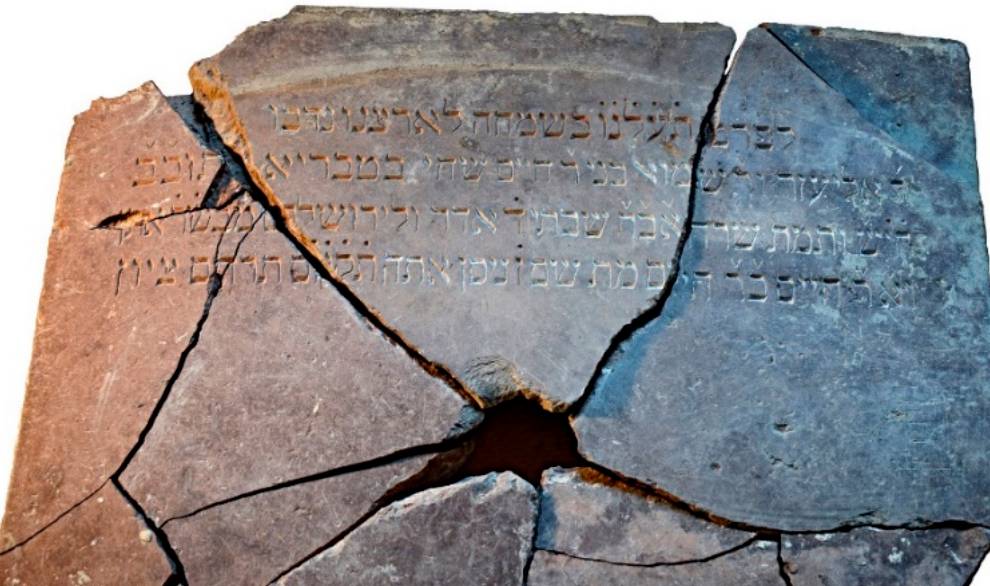
Figure 12. Detail of the inscription. Photo: Jon Seligman, Israel Antiquities